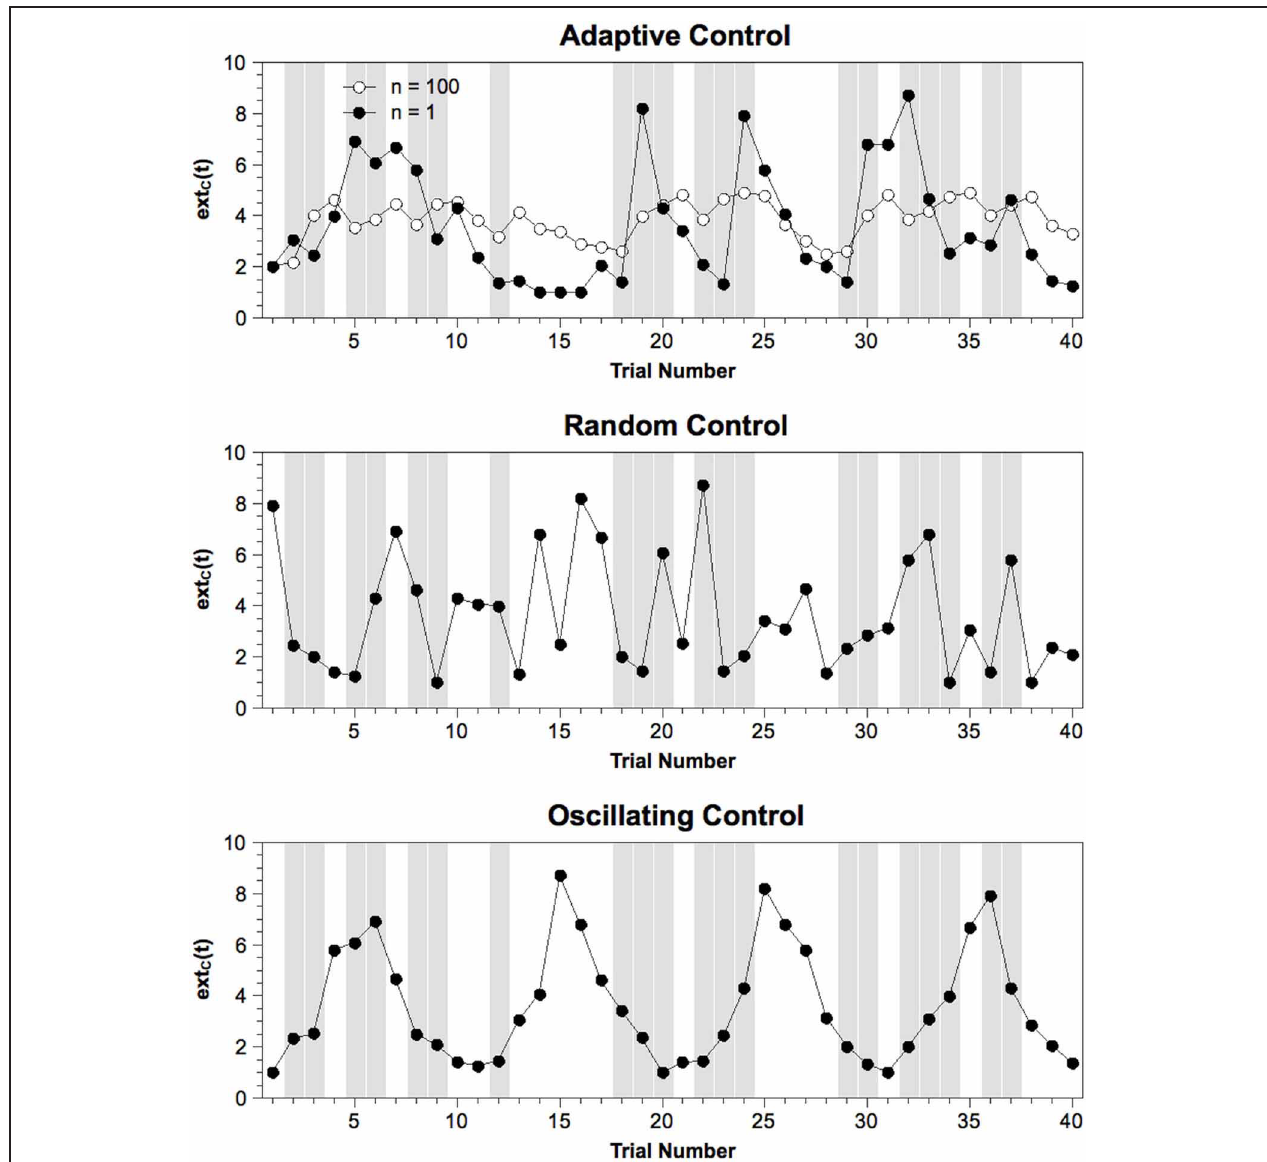
FIGURE 2 | Exemplary sequence of ext C (t) values from one sub-block of each model variant. Gray columns indicate incompatible trials. Note that the set of values is the same across models while only the order of values differs between models. For the Adaptive Control model, mean values averaged